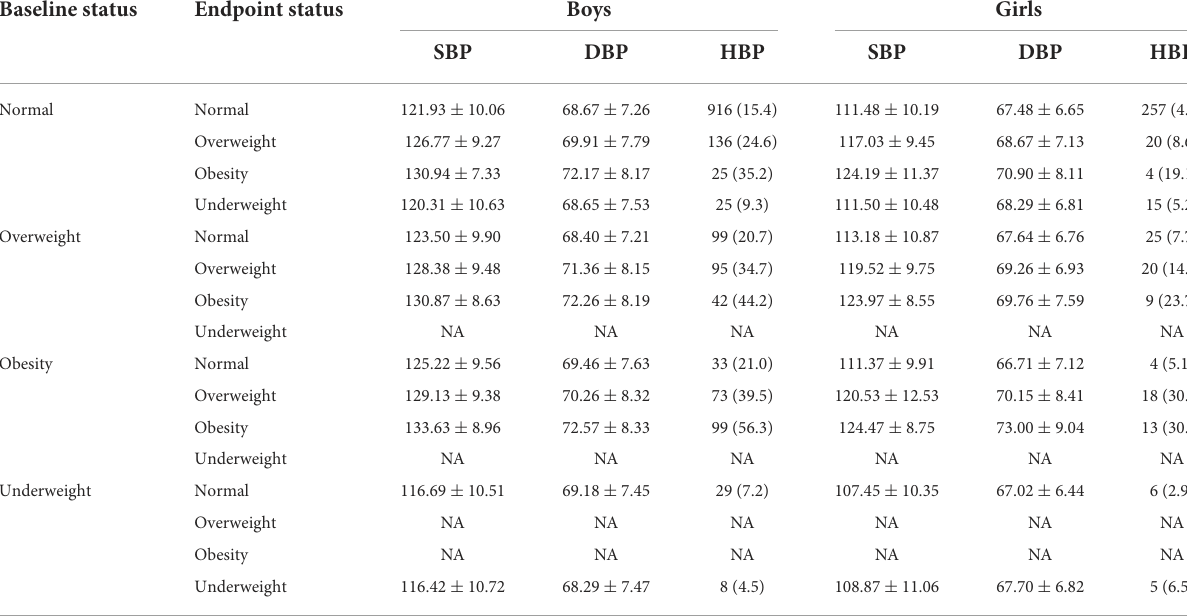
TABLE 2 Blood pressure at late adolescence of children with different weight status.